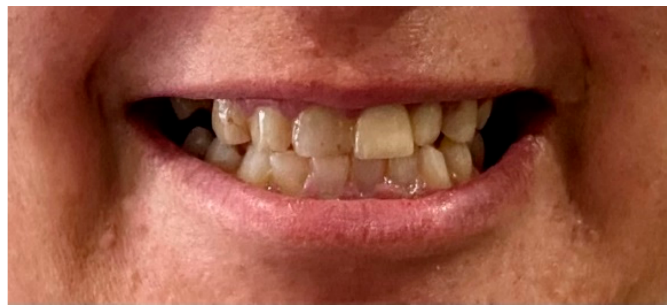
Figure 2. Upper and lower incisors and canines wear.